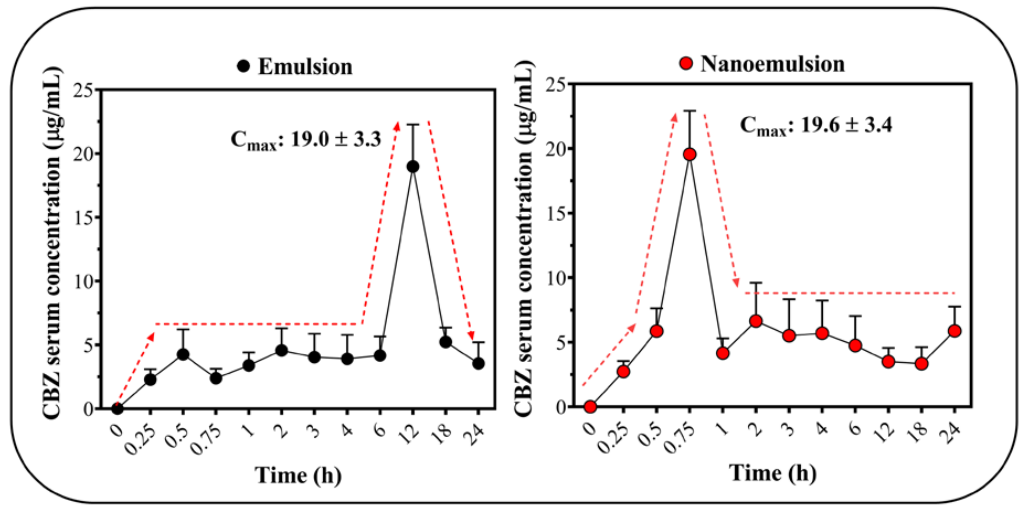
Figure 5. CBZ blood concentration released from coarse emulsion and nanoemulsion formulations.